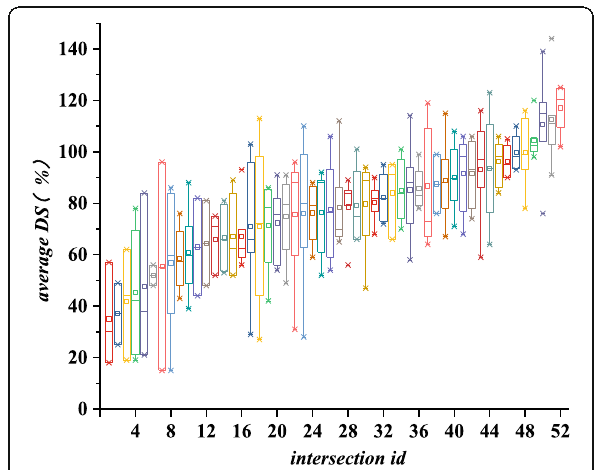
Fig. 11 Distribution of the average degree of saturation in ascending